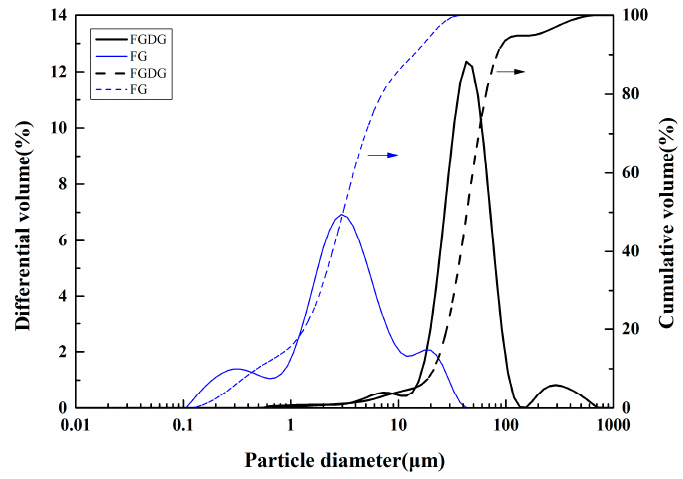
Figure 2. Particle size distribution of FG and FGDG.